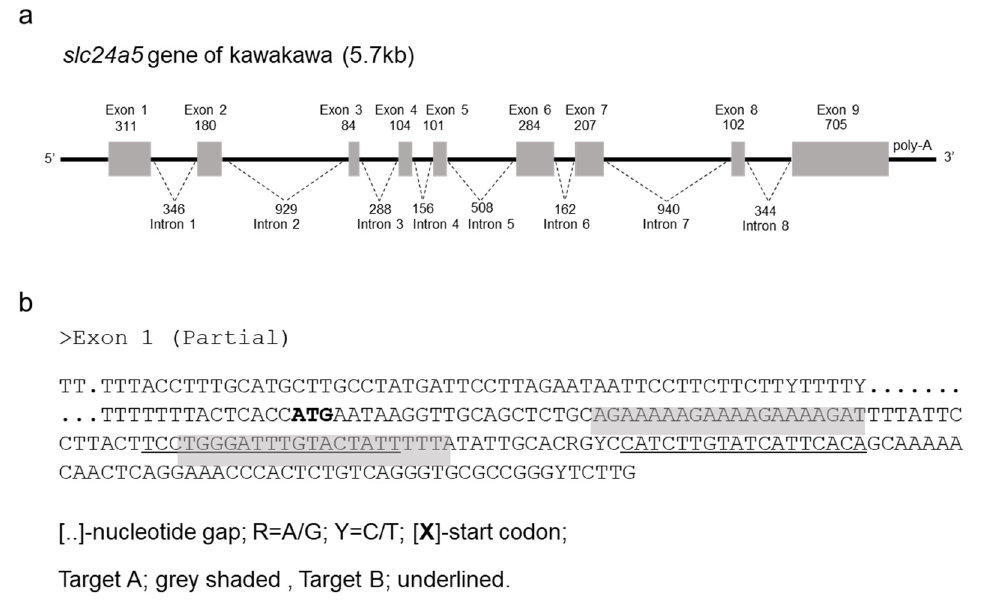
Figure 1. Design of slc24a5 TALENs in kawakawa, Euthynnus affinis . ( a ) Schematic representation of the structure of the complete sequence of the slc24a5 gene . Coding and untranslated exons regions are shown as solid and open boxes, respectively. The number of nucleotides present in each exon and intron is shown. ( b ) slc24a5 TALENs designed to target exon1 of the gene. The exon1 sequence was determined based on the genomes of five different individuals. The grey shaded and underlined sequences indicate the TALEN binding sites of targets A and B, respectively.